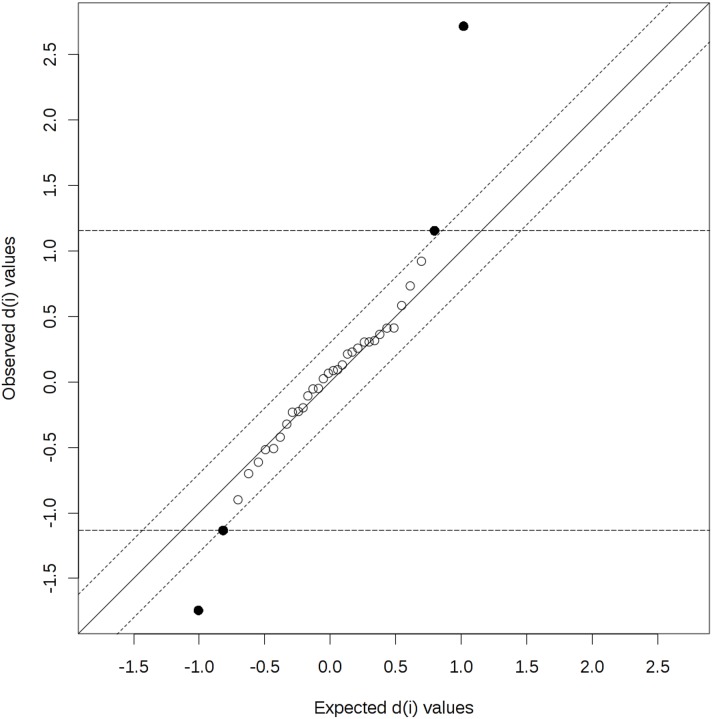
Significant features identified by SAM (Significance Analysis of Microarray (Delta = 0.3).The more the variable deviates from the “observed-expected d” line, the more likely it is to be significant. The bold dots represent features that exceed the specified threshold (cutlow = –1.134, cutup = 1.155). Significant positive compounds (i.e. mean concentration in the serum of the beekeepers directly after a bee sting > mean concentration in the serum of the beekeepers after at least six weeks since the last sting): Glu (d.value = 2.717), 3MHis (d.value = 1.155). Significant negative compounds (i.e. mean concentration in the serum of the beekeepers directly after a bee sting < mean concentration in the serum of the beekeepers after at least six weeks since the last sting): Gln (d.value = –1.744), Met (d.value = –1.134).